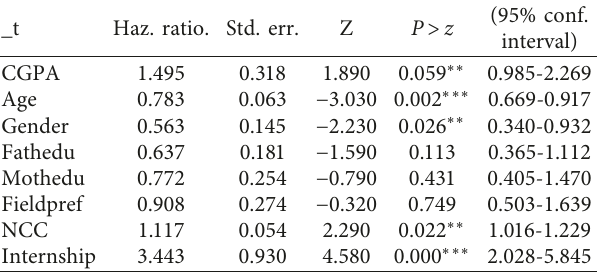
Table 7: Cox PH model estimated hazard rates.